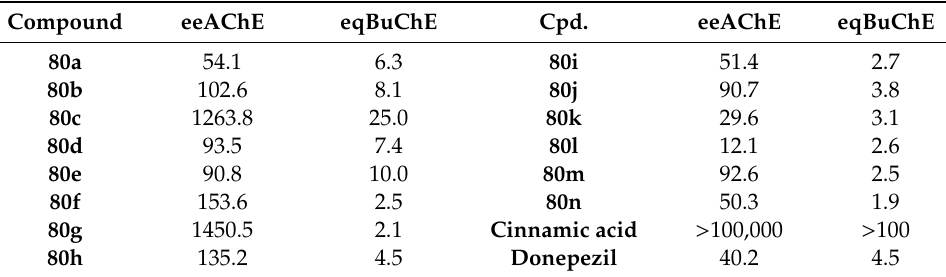
Table 11. Inhibition concentration (IC 50 ) of ChEs activity in nM [11].